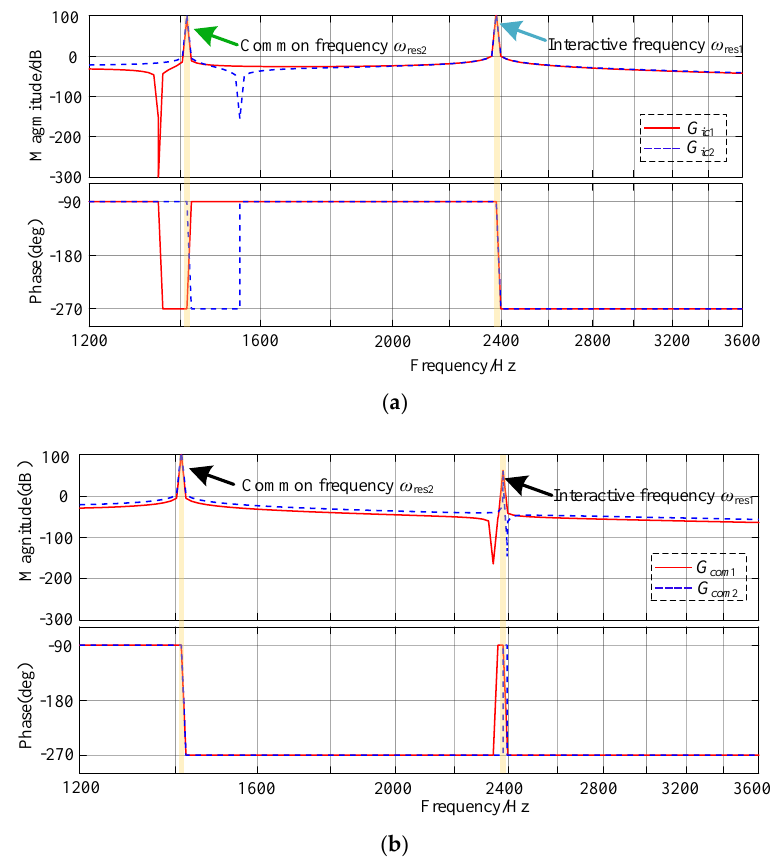
Figure 9. Amplitude frequency characteristics of parallel system with the different capacity. ( a ) The Bode diagram of interactive current G ic ; and ( b ) the Bode diagram of common current G com .